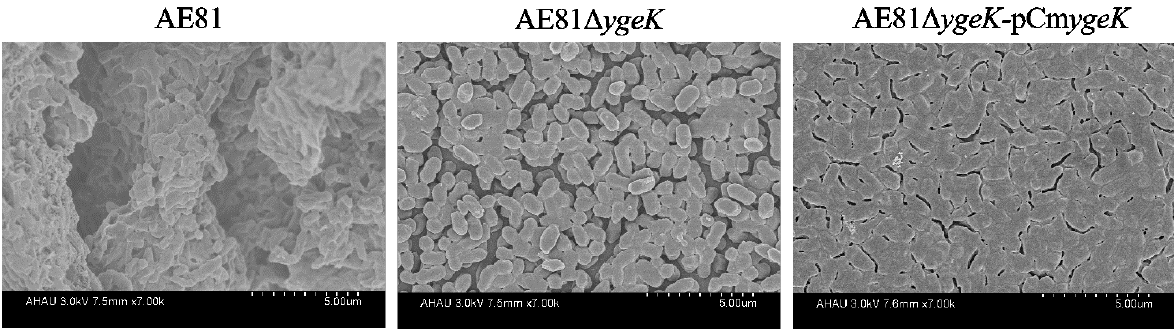
Figure 2. Biofilm structures were observed by scanning electron microscopy (×7000 magnification).